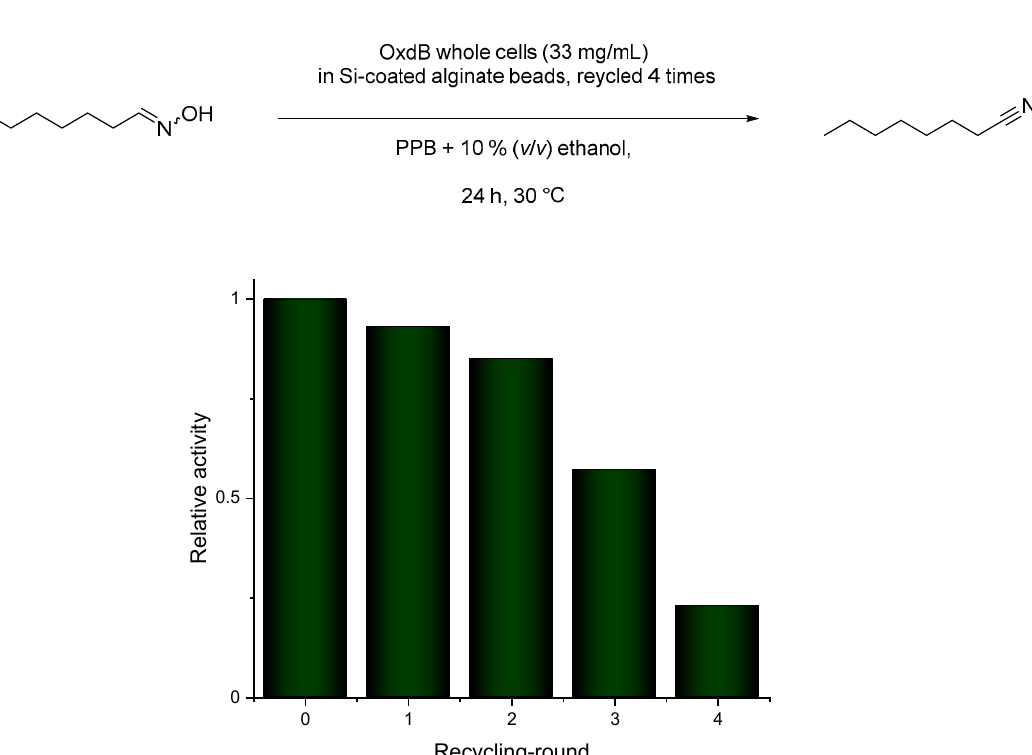
Figure 8. Recycling study of OxdB immobilized in calcium alginate beads coated with TEOS (Si- beads).